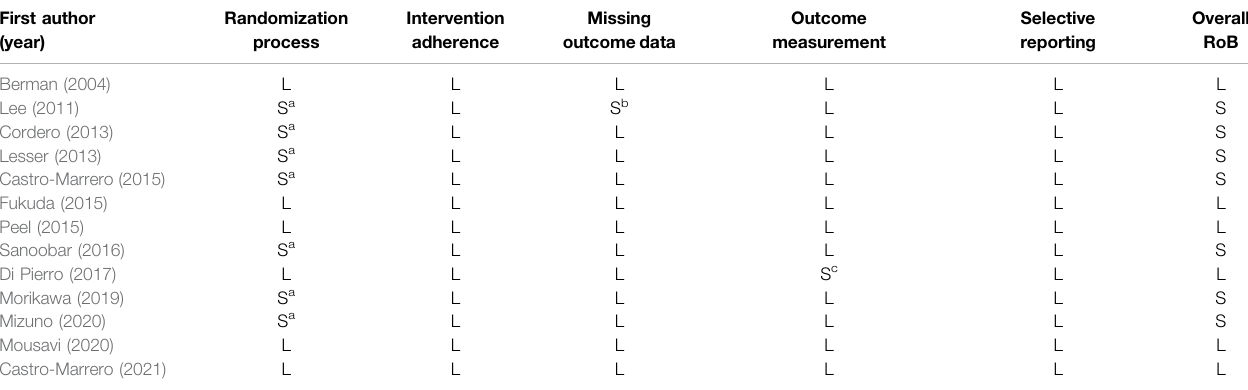
TABLE 3 | Detailed quality assessment of the included studies using the Cochrane risk-of-bias tool, version